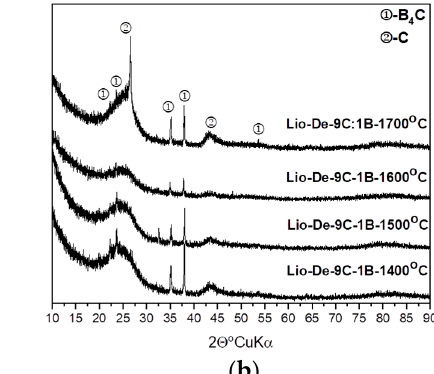
Figure 7. The X-ray patterns of the powders prepared from the mixtures of dextrin: ( a ) recrystallized and ( b ) lyophilized.